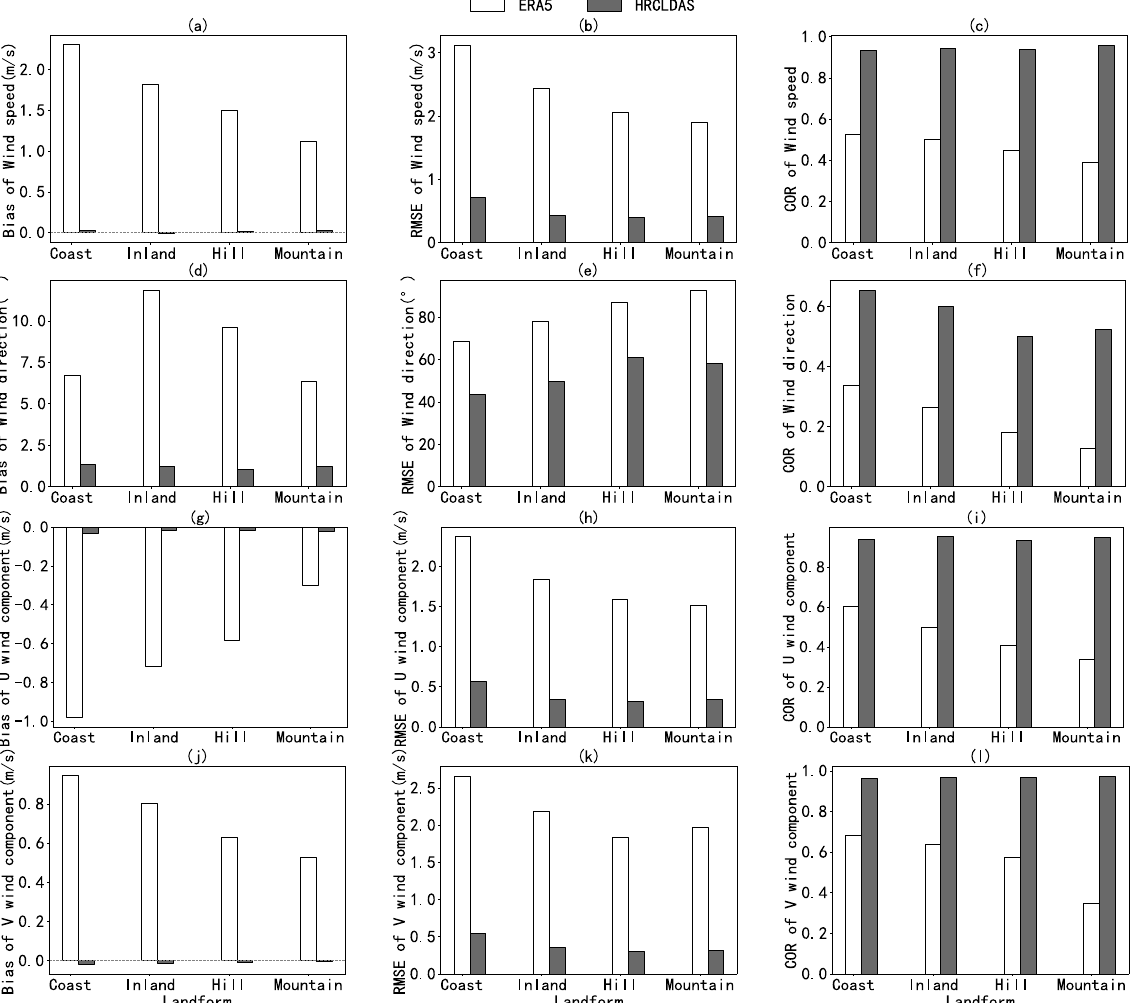
Figure 7. Evaluation indicators of ERA5 and HRCLDAS for different landforms. Bias of near-surface wind speed ( a ), wind direction ( d ), U component ( g ), and V component ( j ); RMSE of near-surface wind speed ( b ), wind direction ( e ), U component ( h ), and V component ( k ); COR of near-surface wind speed ( c ), wind direction ( f ), U component ( i ), and V component ( l ).